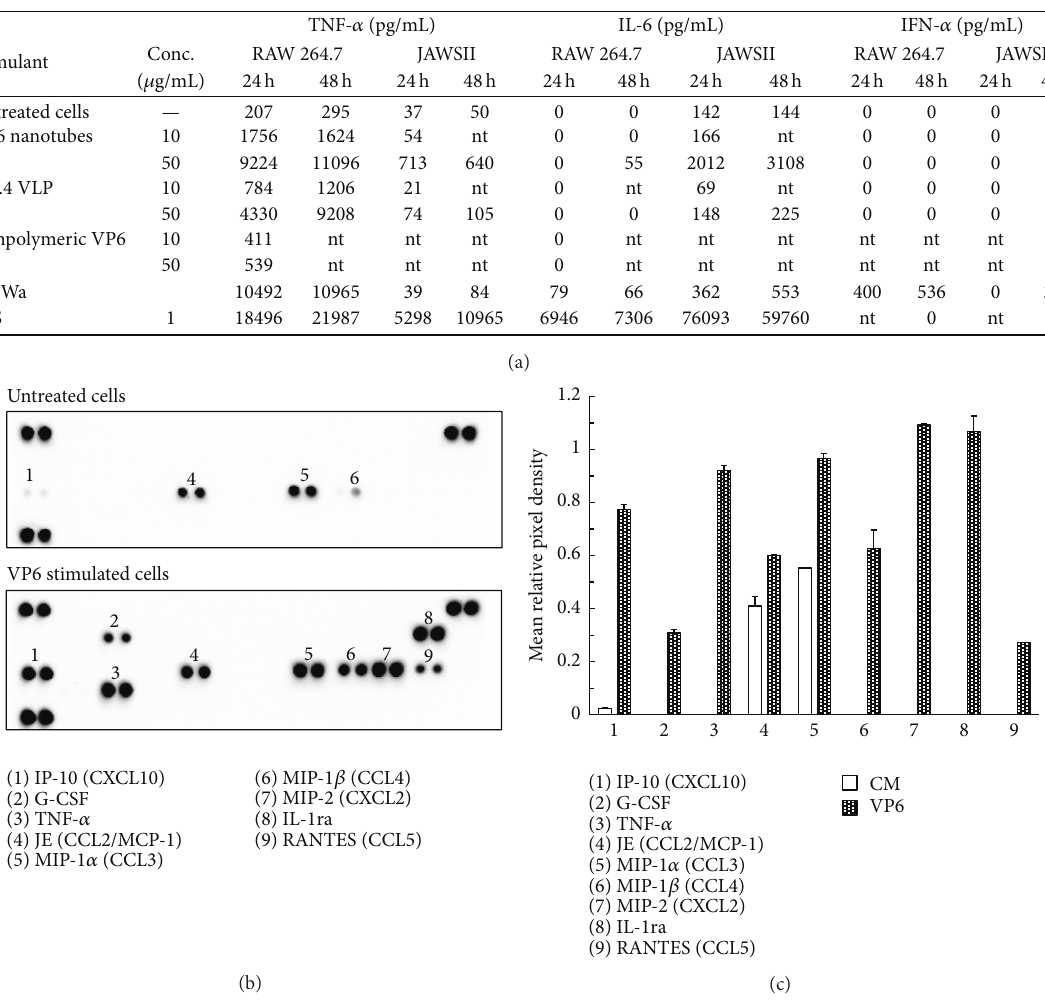
Figure 4: Cytokine production in the supernatants of RAW 264.7 and JAWSII cells. (a) The quantity (pg/mL) of TNF- 𝛼 , IL-6, and IFN- 𝛼 in the supernatants of RAW and JAWSII cells incubated for 24 h or 48 h with 10 𝜇 g/mL and 50 𝜇 g/mL of VP6 nanotubes, NoV GII.4 VLPs, or nonpolymeric VP6. RV Wa, LPS, and culture media only (untreated cells) served as controls. Zero values indicate that the result was below the lowest standard dilution of the assay (62.5 pg/mL for TNF- 𝛼 , 15.6 pg/mL for IL-6, and 12.5 pg/mL for IFN- 𝛼 ). nt = not tested. Shown are the mean values of analysis done at least twice with independent samples. (b) The mouse cytokine multiplex array analysis of RAW 264.7 supernatants after 24 h stimulation with VP6 nanotubes (100 𝜇 g/mL) or fresh culture media (untreated cells). (c) The pixel densities ± SD of the replicates for each visible spot on the arrays, calculated using ImageJ software and